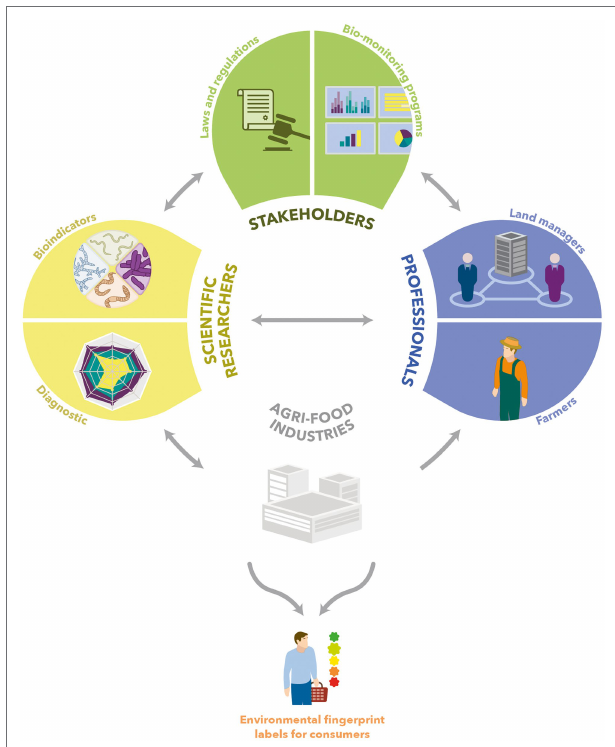
FIGURE 8 | Schematic overview of field soil quality measurement and its actors. Scientific researchers explore microbial diversity in order to create repositories and develop bioindicators. These bioindicators are forwarded to the agri-food industry to make them largely accessible to professionals such as farmers or land managers. In addition, exchanges with stakeholders of bio-monitoring programs take